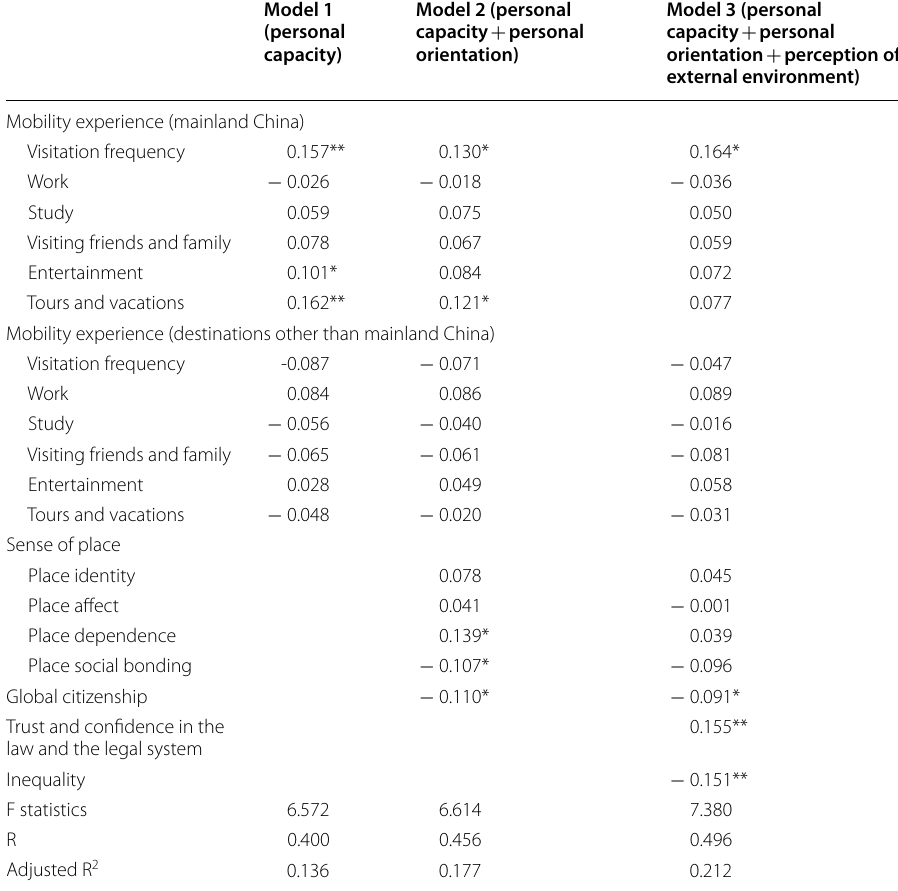
Table 3 Stepwise regression analysis between socio‑political variables and individuals’ intention to migrate to mainland